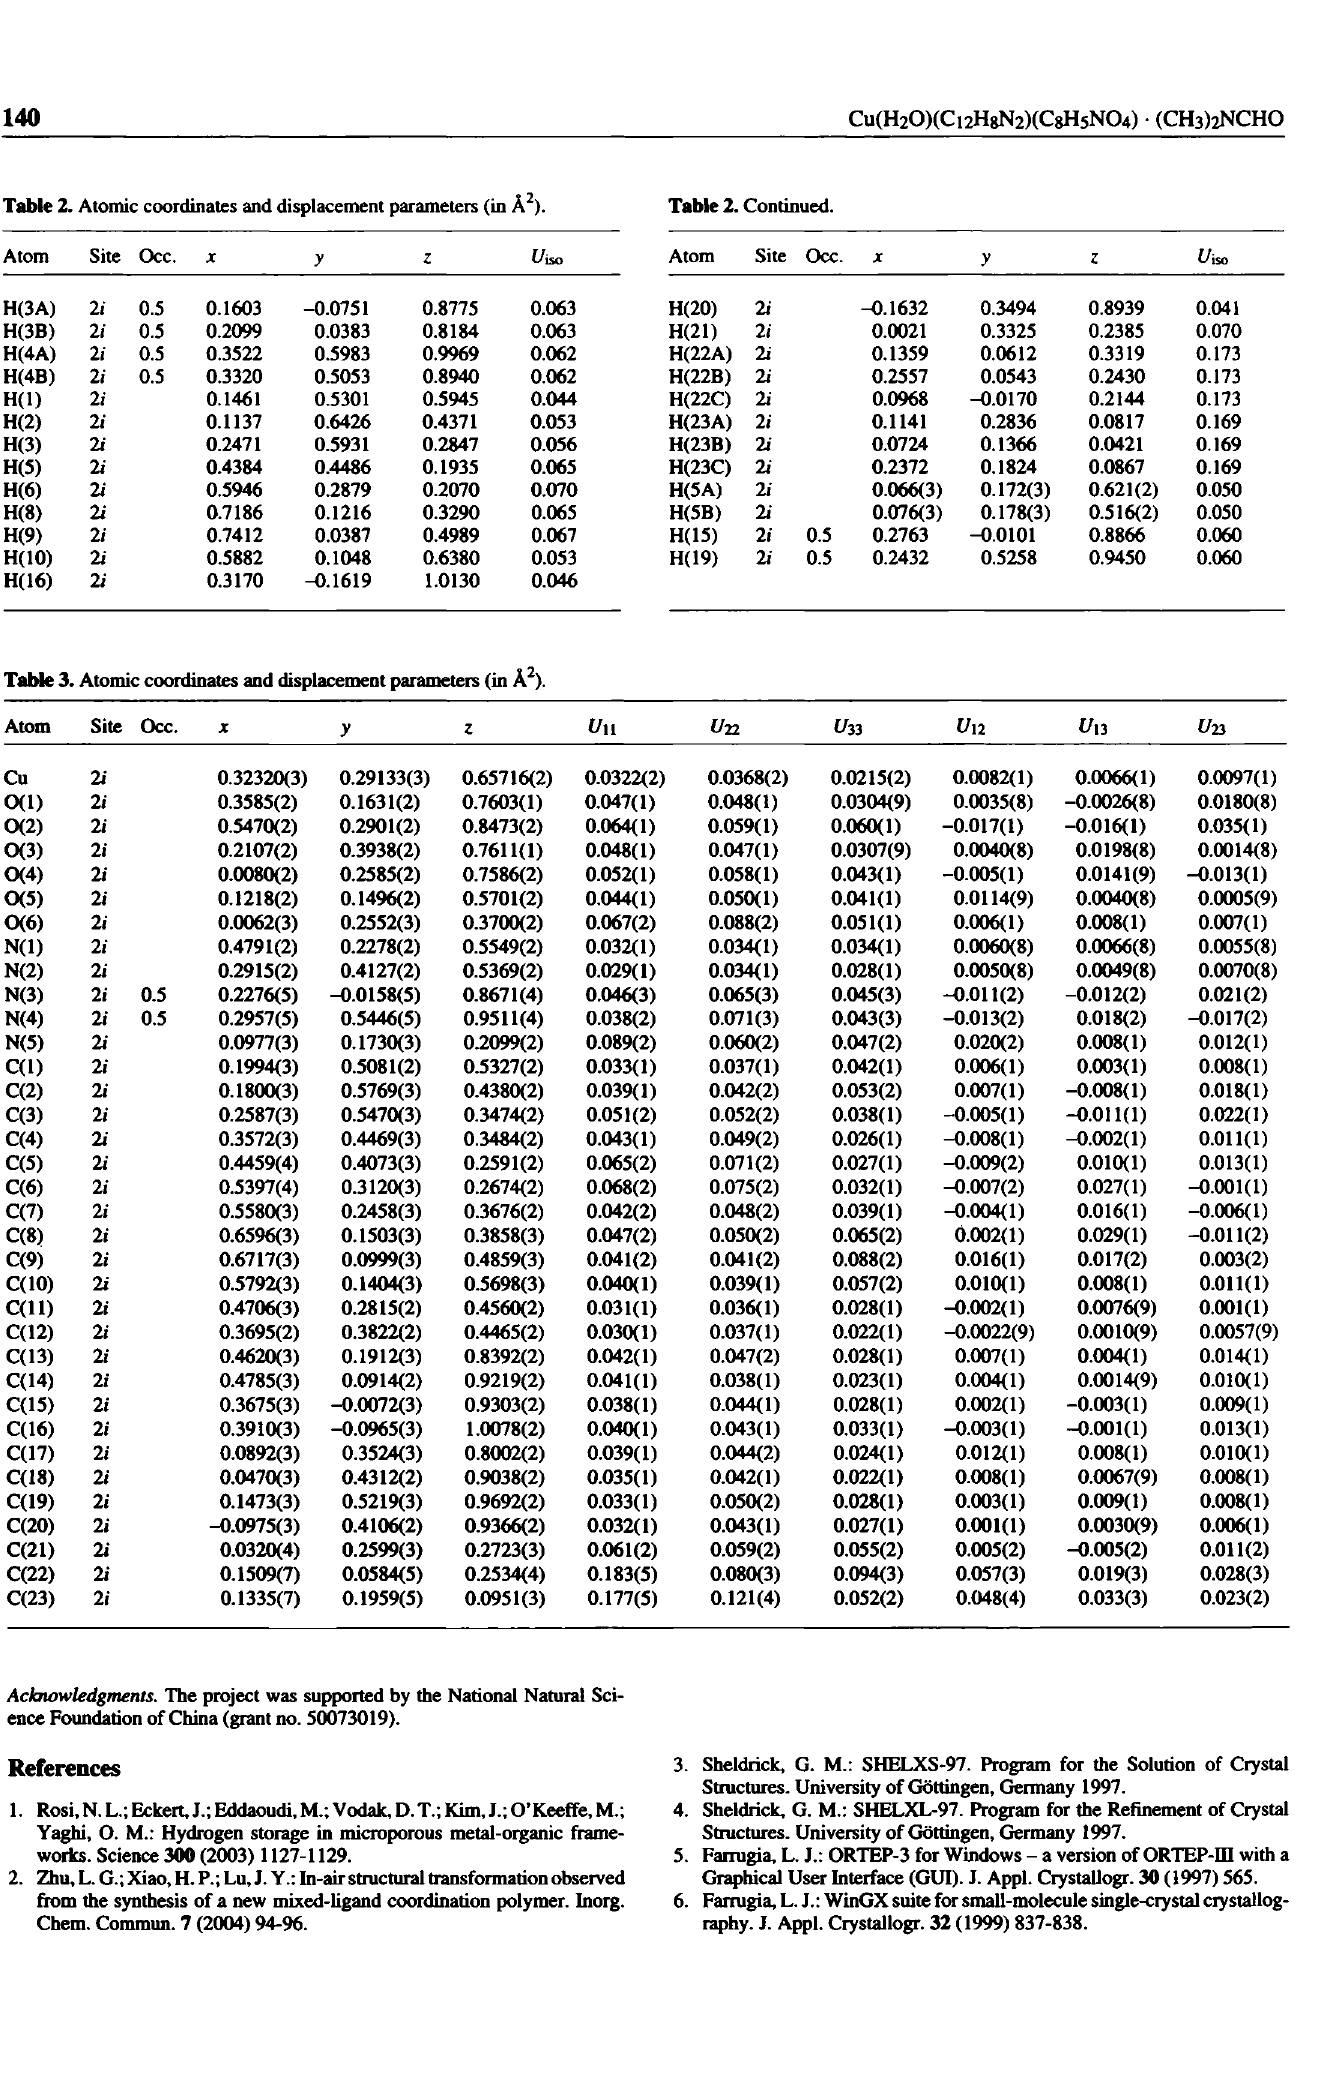
Table 3. Atomic coordinates and displacement parameters (in A 2